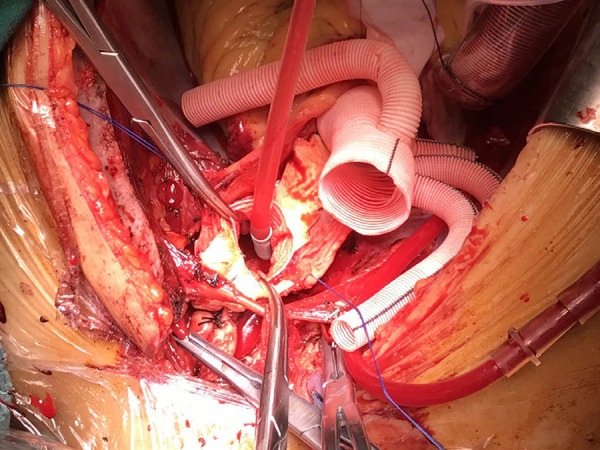
Implanting the stented graft into the descending aorta under direct vision, followed by total arch replacement with a fourbranched vascular graft (Hemashield Platinum; Maquet, Wayne, NJ, USA); a specific anastomotic order for aortic reconstruction is conducted starting by the proximal descending aorta, followed by the left carotid artery, then the ascending aorta, the left subclavian artery, and lastly, the innominate artery.